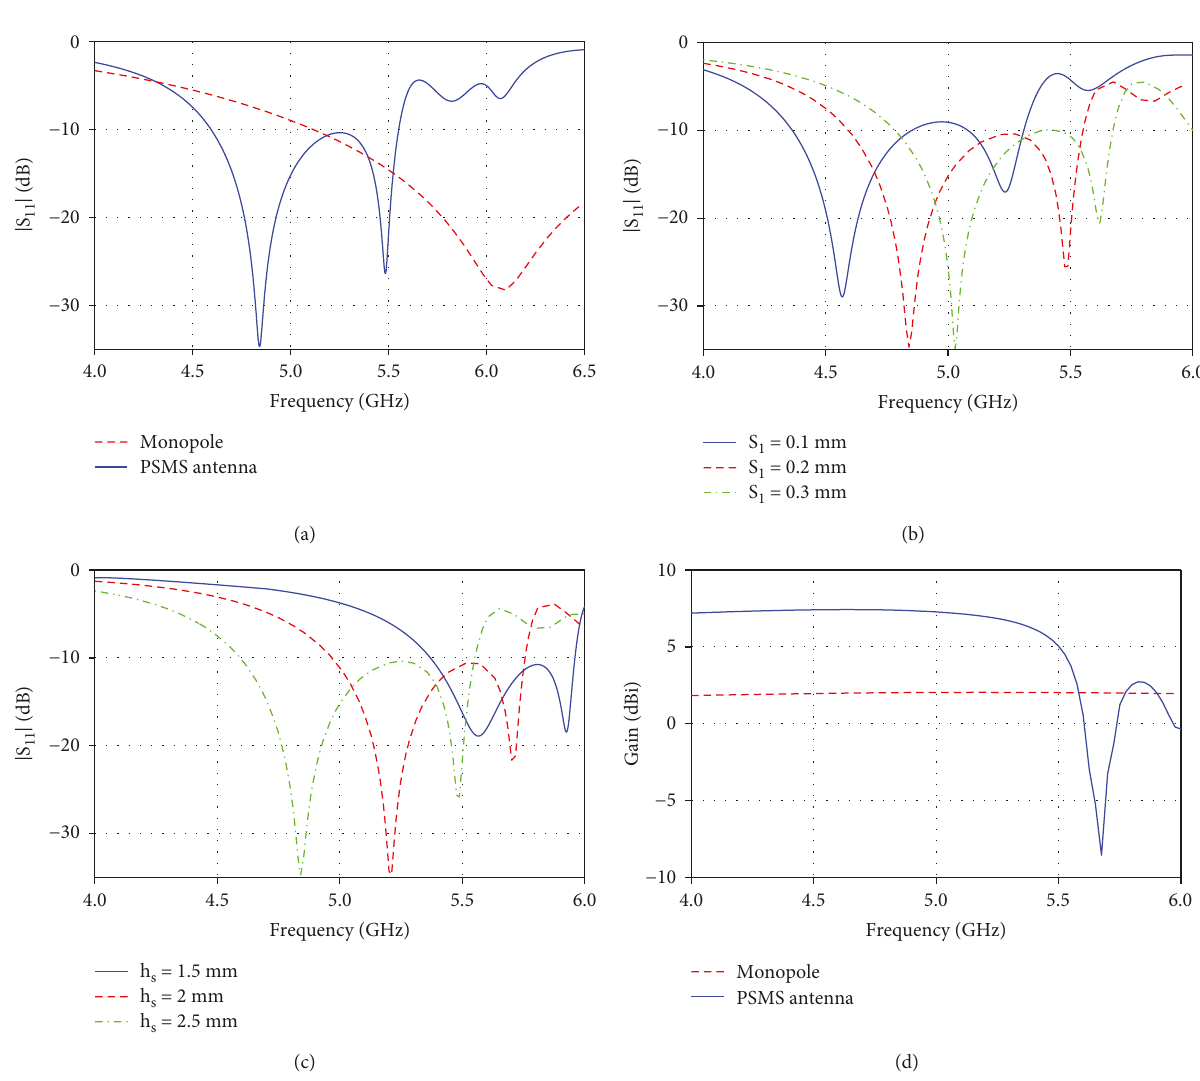
1 . (c) Parametric study on height